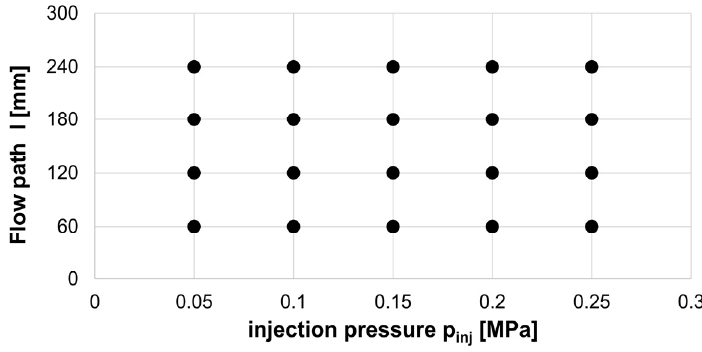
Figure 6. Parameter combinations for injection